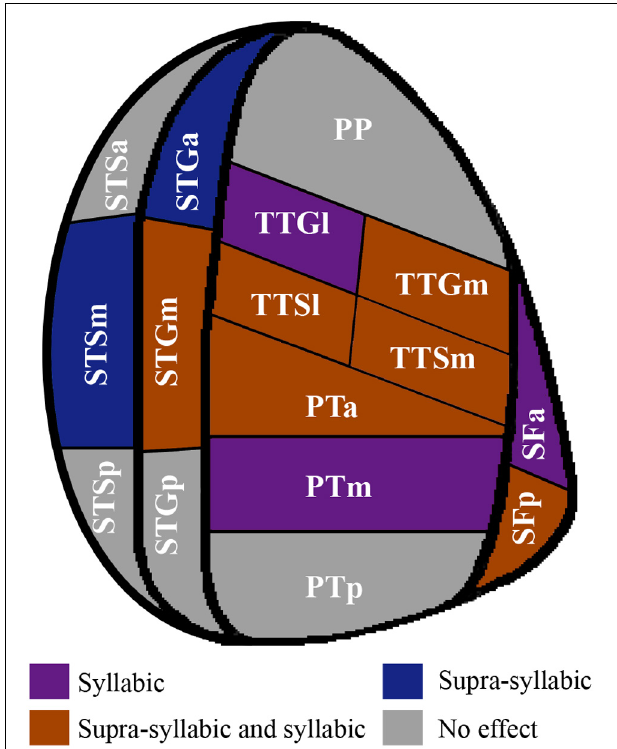
FIGURE 6 | Patterns of main effects of syllabic and supra-syllabic complexity observed in exploratory STP and STS ROI analysis. The results are shown on a flattened schematic representation of STP and STS showing the parcellation used in this study (different areas shown not to scale). Areas in dark purple are those that exhibited a main effect of syllabic complexity, areas in blue are those that exhibited a main effect of supra-syllabic complexity, areas in orange are those that exhibited where both an effect of syllabic and supra-syllabic complexity were observed and areas in gray are those that exhibited no effect was observed. Legend: PP, planum polare; TTG, transverse temporal gyrus (m, medial, l, lateral); TTS, transverse temporal sulcus (m, medial, l, lateral); PT, planum temporale (a, anterior, m, middle, p, posterior); SF, caudal Sylvian fissure (a, anterior, p, posterior); STG, superior temporal gyrus (a, anterior, m, middle, p, posterior); STS, superior temporal sulcus (a, anterior, m, middle, p,